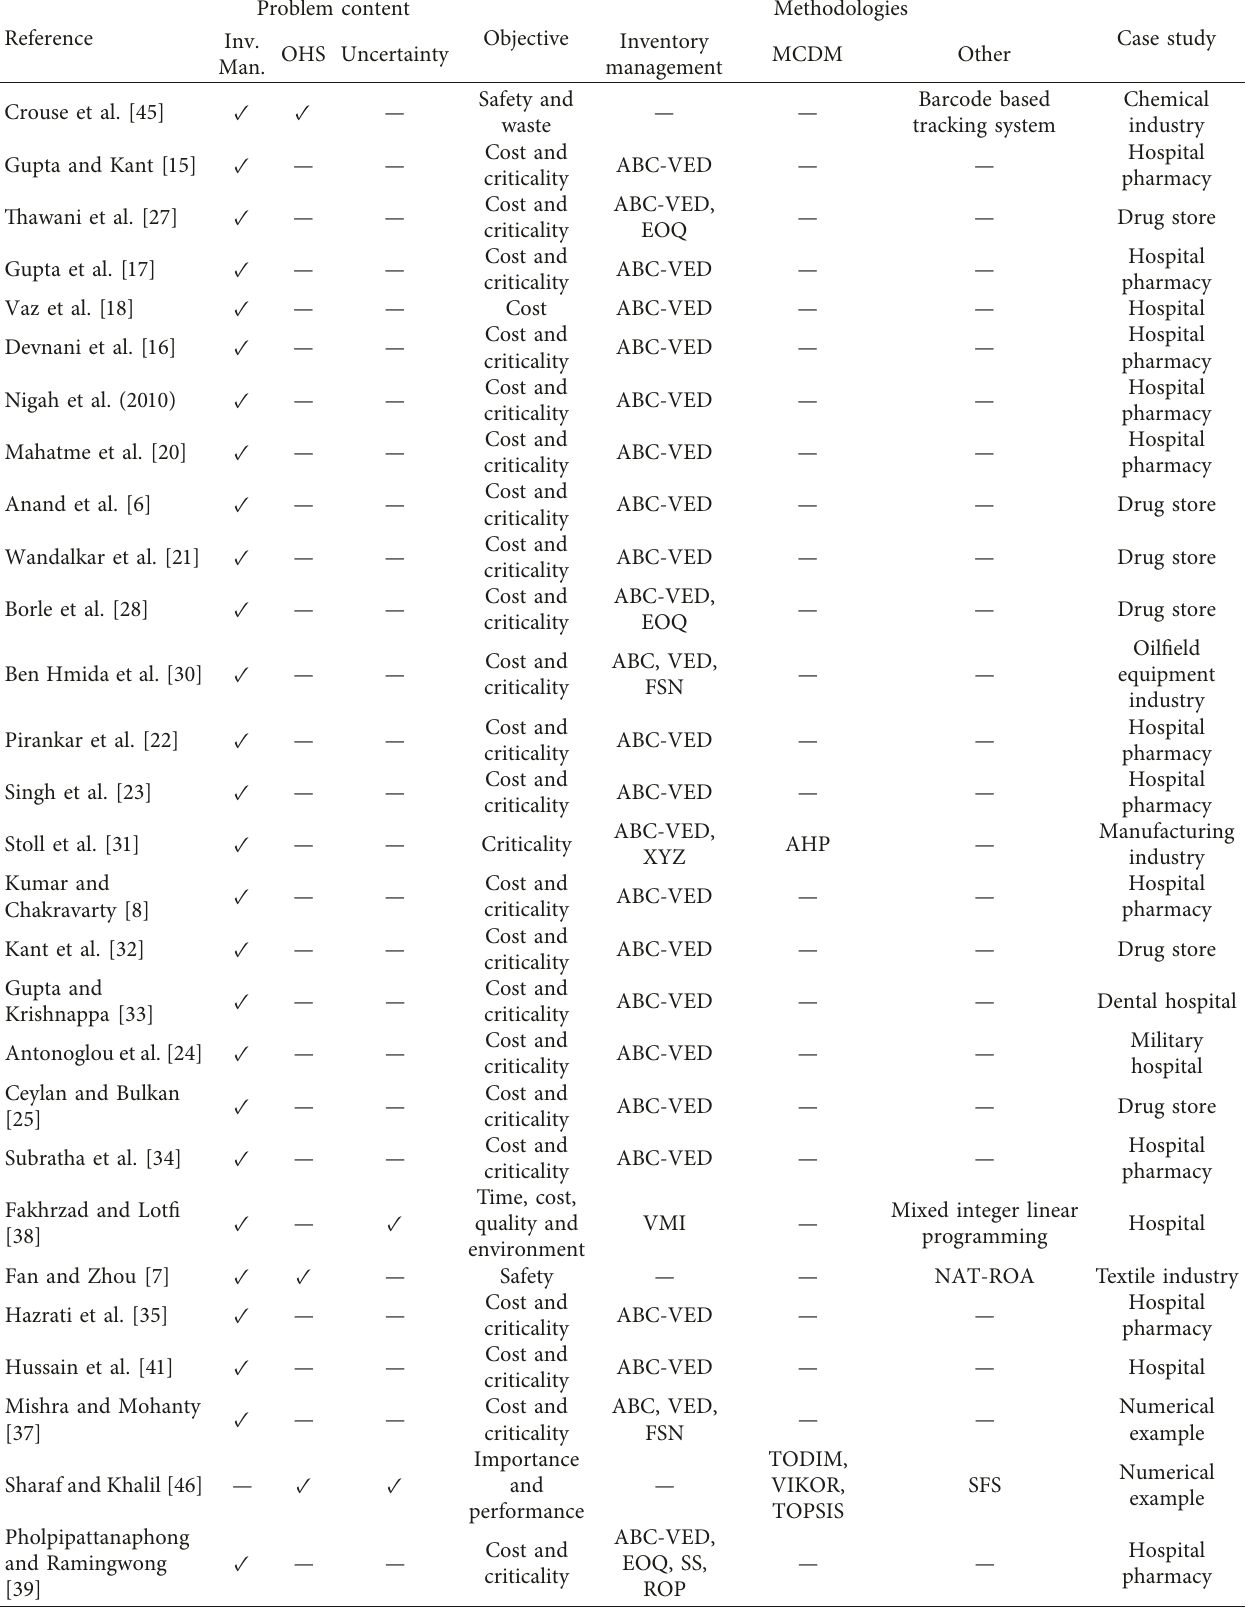
Table 1: Classification of literature survey